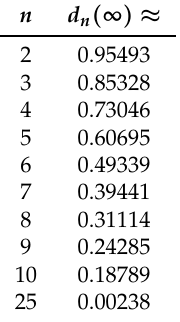
Table 3. The simplicial horoball